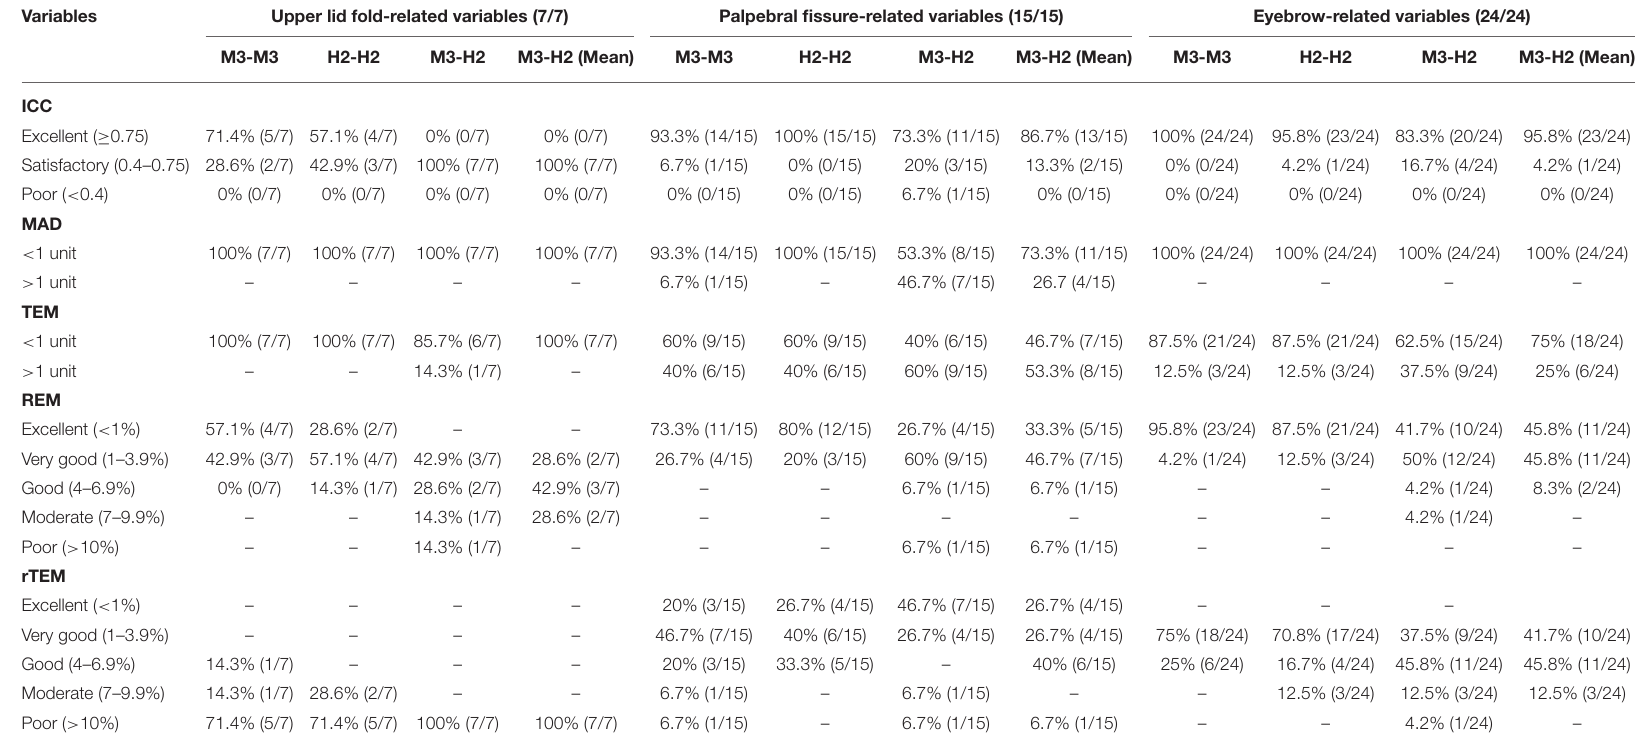
TABLE 6 | Percentage of different periocular measurement variables in each reliability rating classification for VECTRA M3 and